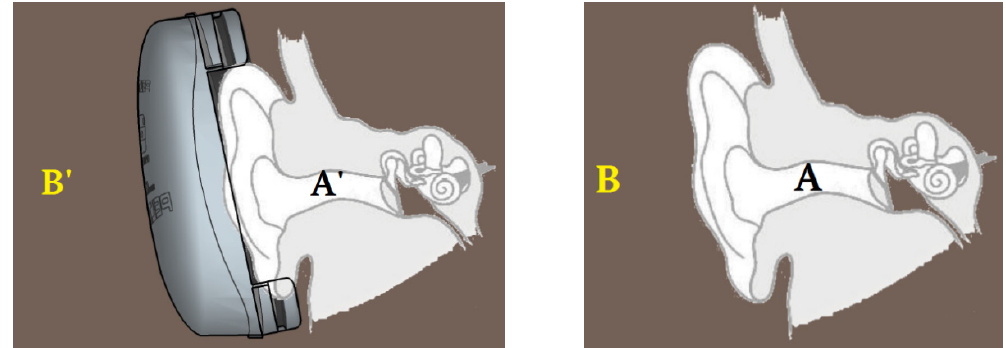
Figure 1. Schematic diagram for the measurement location in the evaluation of the attenuation of HPDs via the F-MIRE test method.